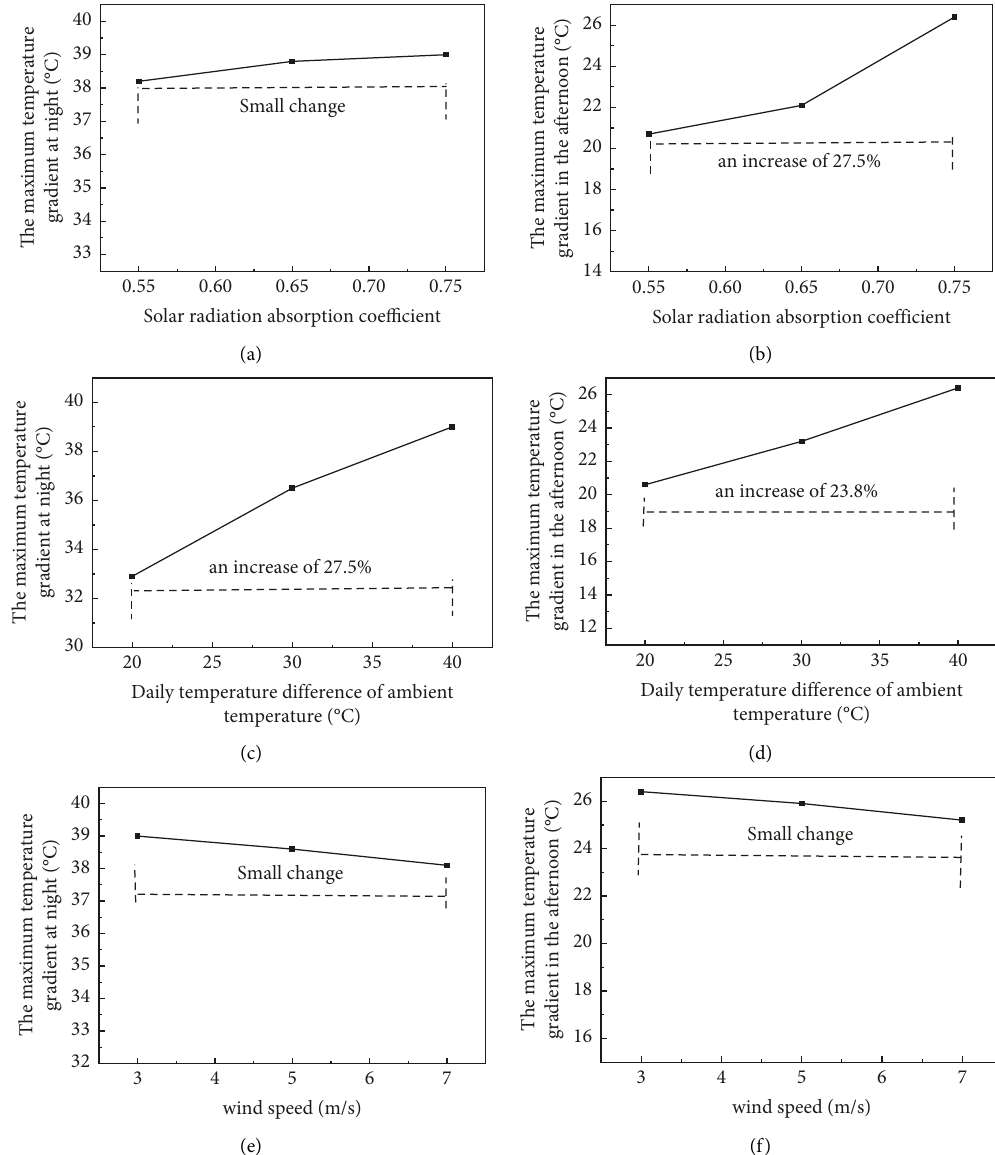
Figure 15: Sensitivity analysis on temperature field: (a) influence of solar radiation absorption coefficient (at night), (b) influence of solar radiation absorption coefficient (in the afternoon), (c) influence of daily temperature difference of ambient temperature (at night), (d) influence of daily temperature difference of ambient temperature (in the afternoon), (e) influence of wind speed (at night), and (f) influence of wind speed (in the